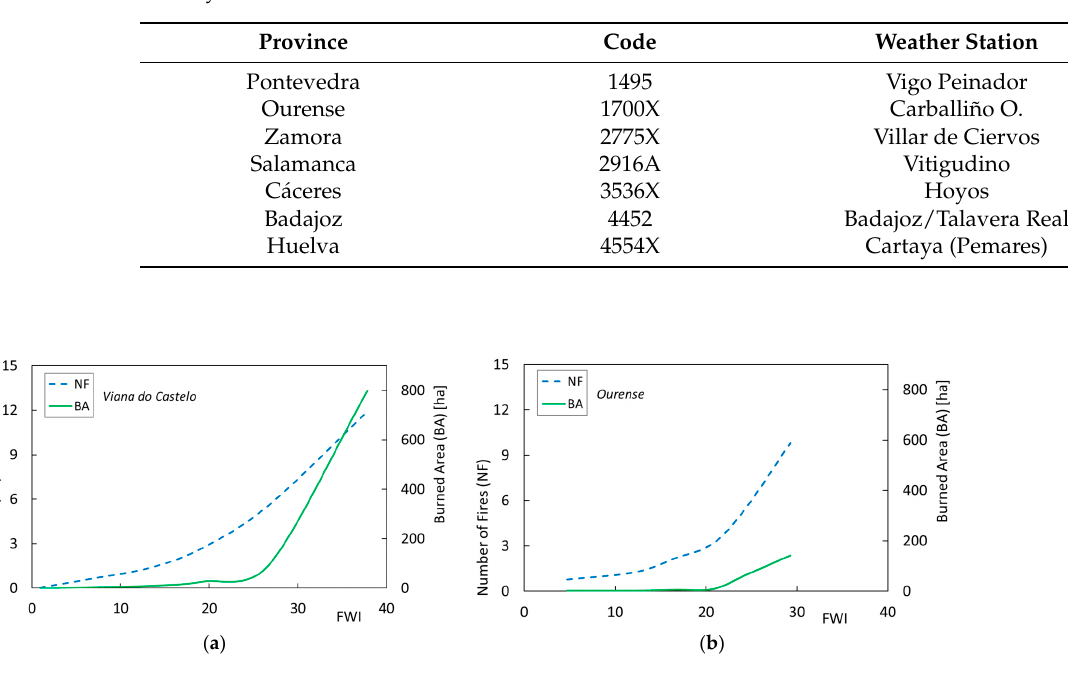
Table A2. Spanish weather stations used. The code and the meteo station designations are those used by AEMET.